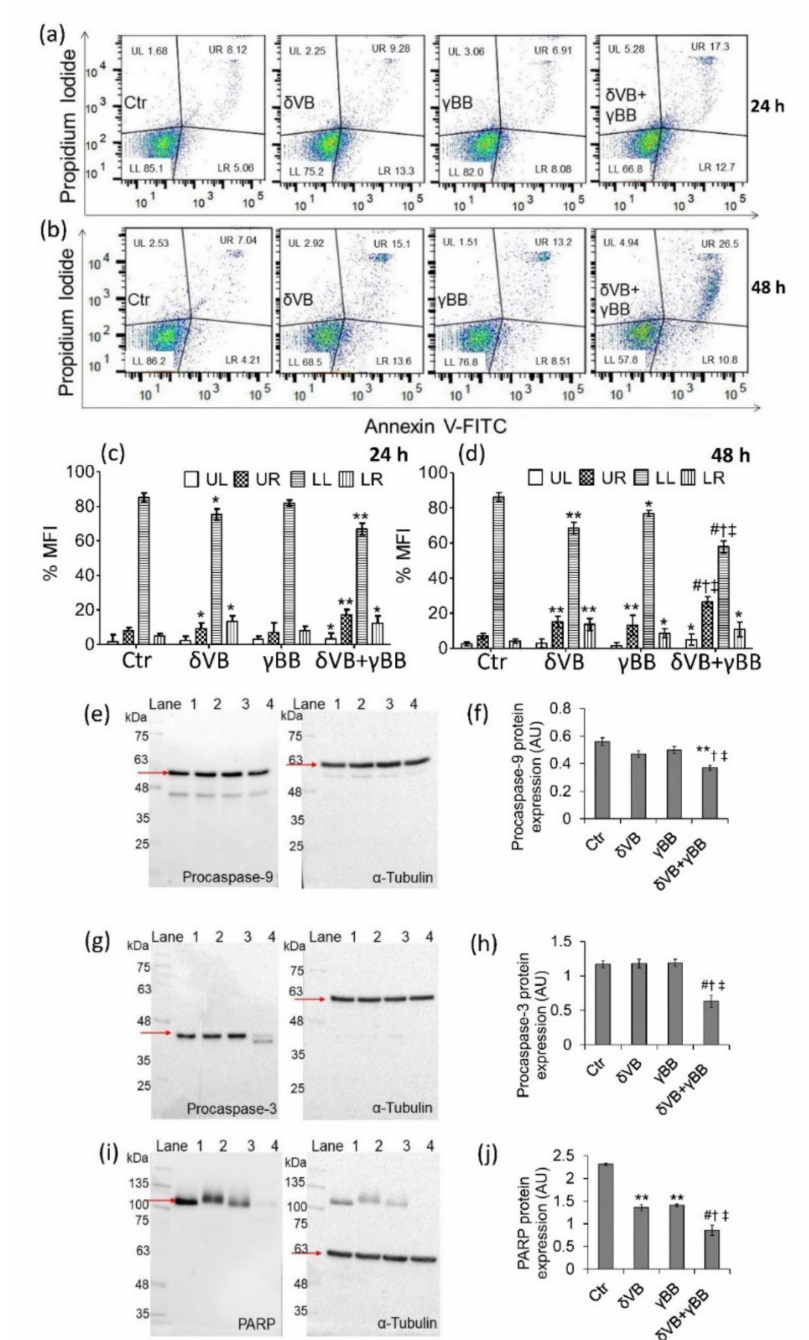
Figure 4. Apoptotic Cal 27 cell death. ( a – d ). Representative dot plots and analysis of annexin V-FITC and PI-stained cells analyzed by flow cytometry. The percentage of cells is reported in the quadrants; lower left (LL), viable cells; upper left (UL), necrotic cells; lower right (LR), early apoptotic cells; upper right (UR), late apoptotic cells. Data are expressed as mean ± SD of n = 3 experiments. At least 10,000 events were acquired. Full-length blots and protein expression levels of ( e , f ) procaspase-9, ( g , h ) procaspase-3, and ( i , j ) PARP from treated for 48 h with δ VB (2 mM), γ BB (2.5 mM), δ VB + γ BB (2 mM + 1.62 mM), or HBSS-10 mM Hepes (Ctr). Lane 1 = Ctr; lane 2 = δ VB, lane 3 = γ BB, lane 4 = δ VB + γ BB. Analysis of densitometric intensity was calculated with Image J software. Arbitrary units (AU) of protein expression were quantified using α -tubulin, as internal control. * p < 0.05 vs. Ctr, ** p < 0.01 vs. Ctr, # p < 0.001 vs. Ctr, † p < 0.05 vs. δ VB, ‡ p < 0.05 vs. γ